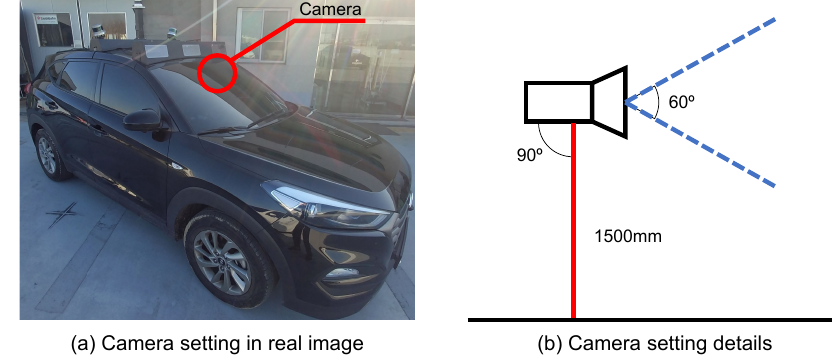
Figure 3. The camera setting in the data-collecting platform.